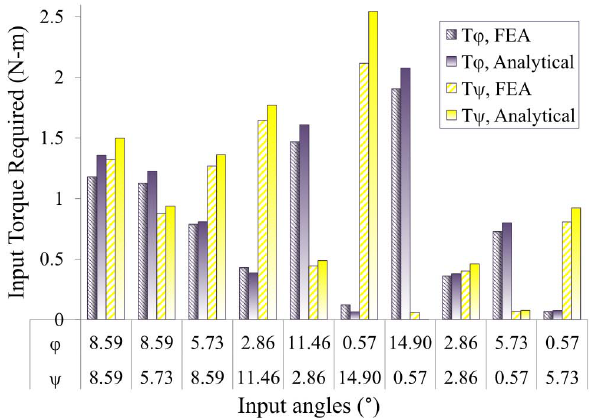
Figure 6. Comparison of FEA and analytical models at ten sets of command angles. T φ and T ψ are torque required for given rotation about the φ and ψ axes, respectively. Table 5. Static analysis of connecting structures. All values are av- erages over eight representative sets of command angles. Rotational error is a root sum square di ff erence from zero and command an- gles. Solid Hollow Square Square Circle